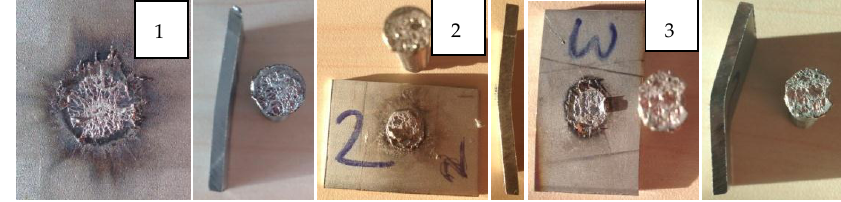
Figure 14. Macro images of split studs (1-140 V, 2-160 V, 3-180 V) and curvature of plates as examples.